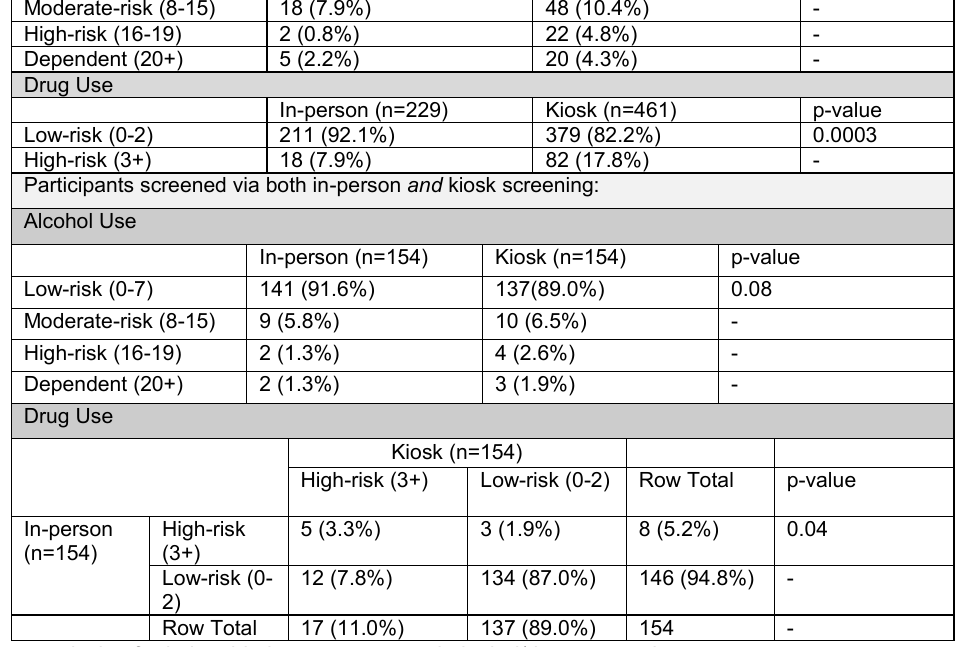
Figure 3 . Intention-to-treat analysis of relationship between reported alcohol/drug use and survey